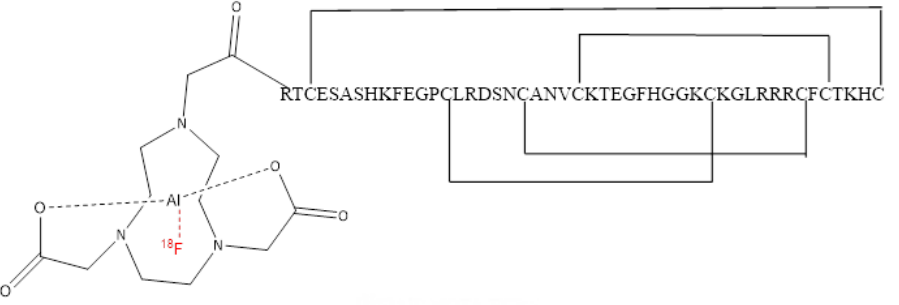
Figure 1. Structure of [ 18 F]AlF ‐ NOTA ‐ KCNA3P.